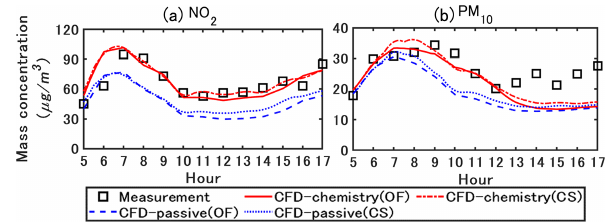
Figure 4. Measured and simulated NO 2 and PM 10 concentra- tions. The values are spatially averaged in the street canyon (27 . 5 ≤ x ≤ 55 , 0 ≤ z ≤ 8 . 5m). CFD–passive and CFD-chemistry denote the CFD simulation without and with chemistry coupling, respectively. OF and CS denote the simulated concentrations based on OpenFOAM and Code_Saturne, respectively. All concentrations are represented in local time (GMT +